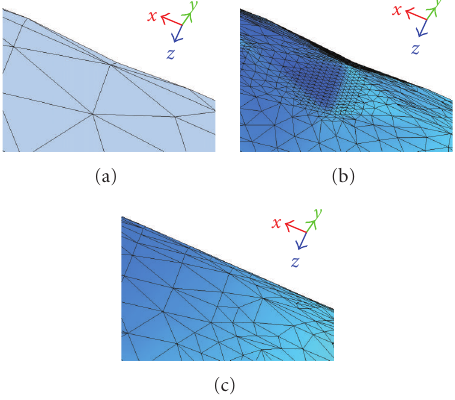
Figure 16: Detail of the area behind the blade of Figure 15, showing initial grid (a) dependency with artificial step created (b), and no dependency with projection (c).